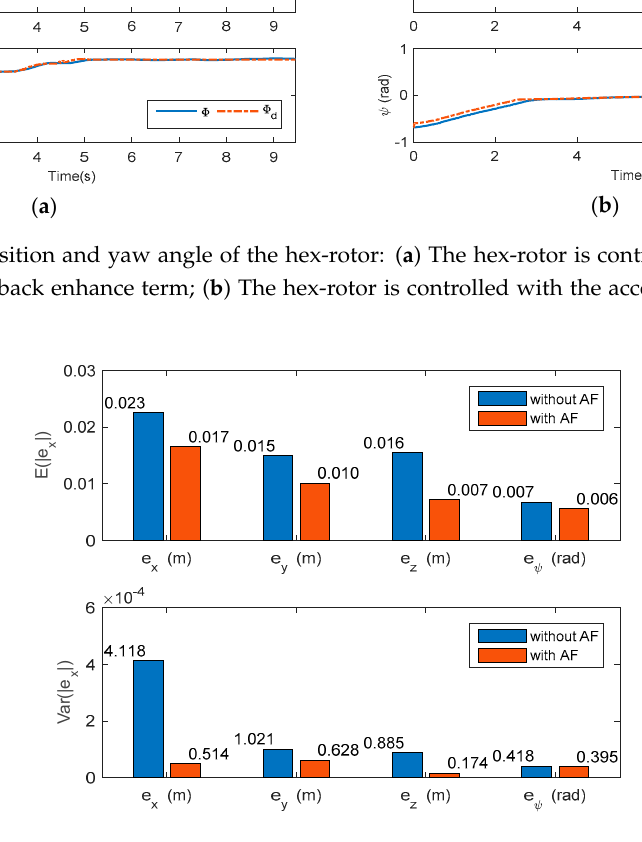
Figure 10. Target position in the operational space when hex-rotor is controlled with and without the acceleration feedback enhanced term, respectively.